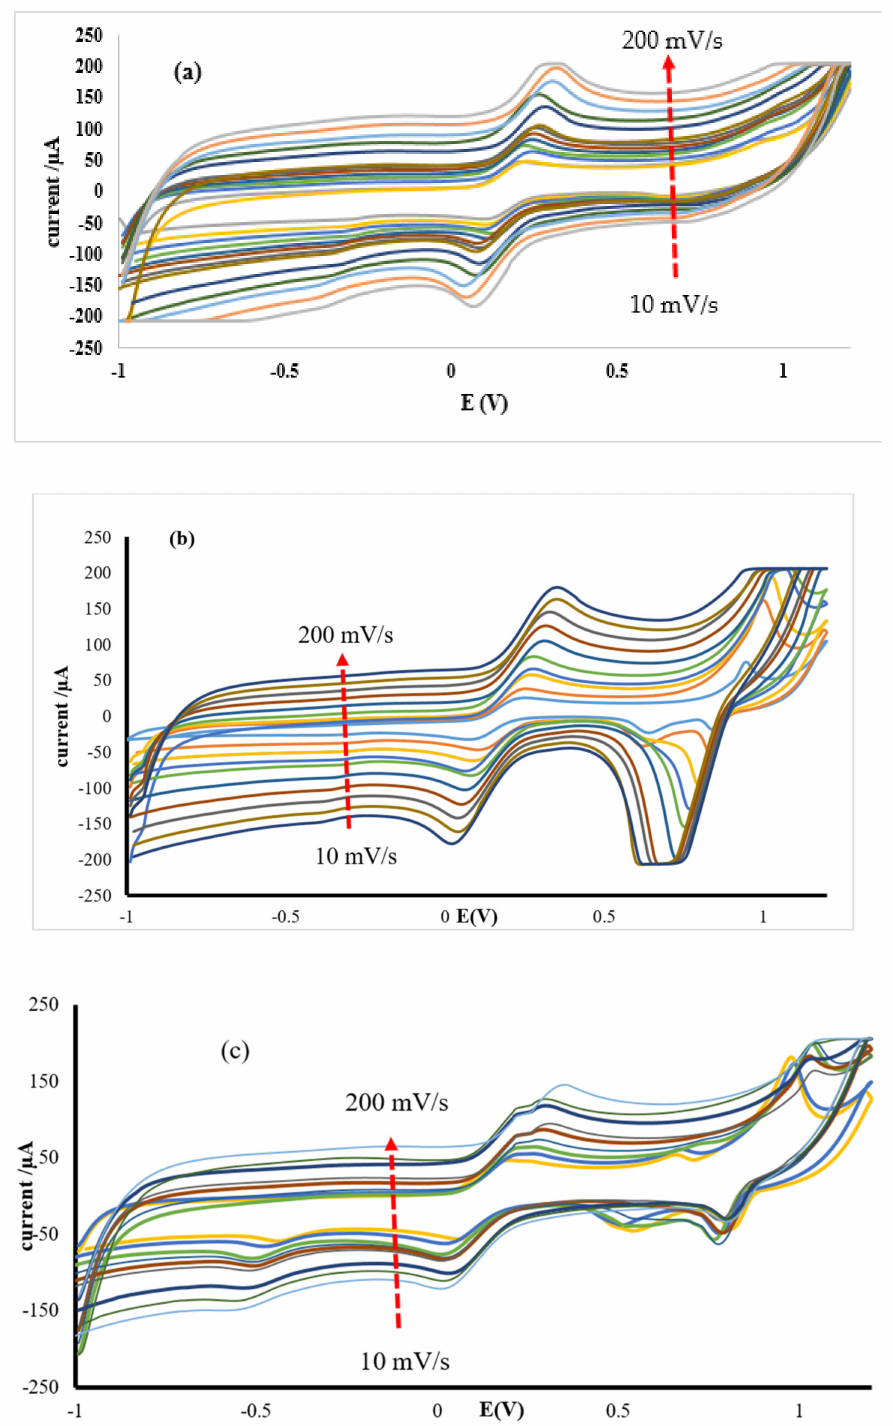
Figure 11. The e ff ect of scan rate (10–200 mV / s) on cyclic voltammograms of 10 mM K 3 [Fe(CN) 6 ] in 0.1 M KCl at pH ≈ 7 for ( a ) SPCE / GPE / ZnO NPs, ( b ) SPCE / LPE / ZnO NPs and ( c ) SPCE / OPE / ZnO NPs. A linear pattern was observed in a plot of peak currents I pa / I pc versus ν 1 represented by the